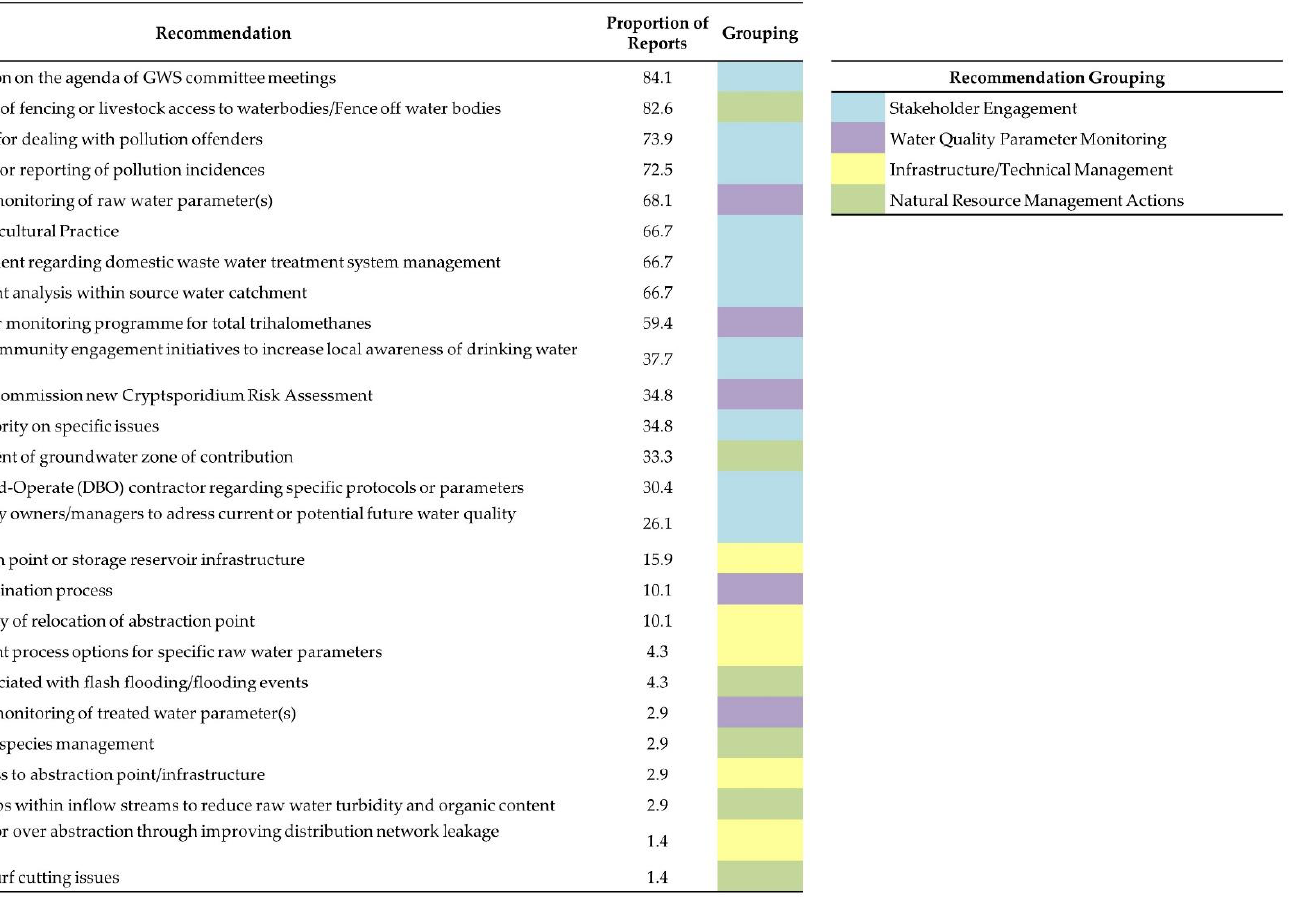
Figure 6. Summary of recommendations from 70 preliminary drinking water source protections reports for Group Water Schemes abstracting from surface water sources.